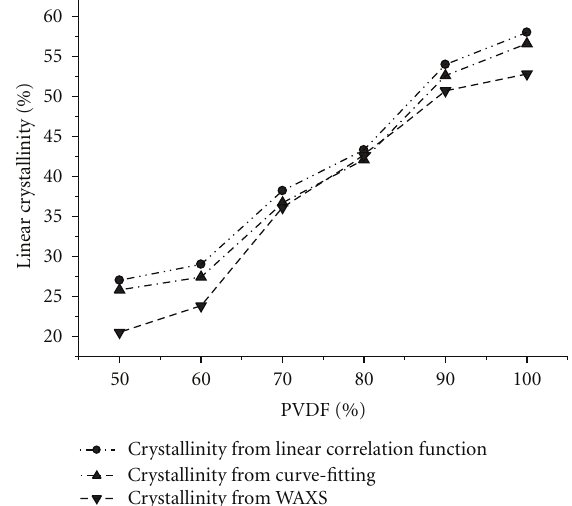
Figure 3: Linear crystallinity values deduced from linear correla- tion function γ ( r ) analysis, curve-fitting, and WAXS.